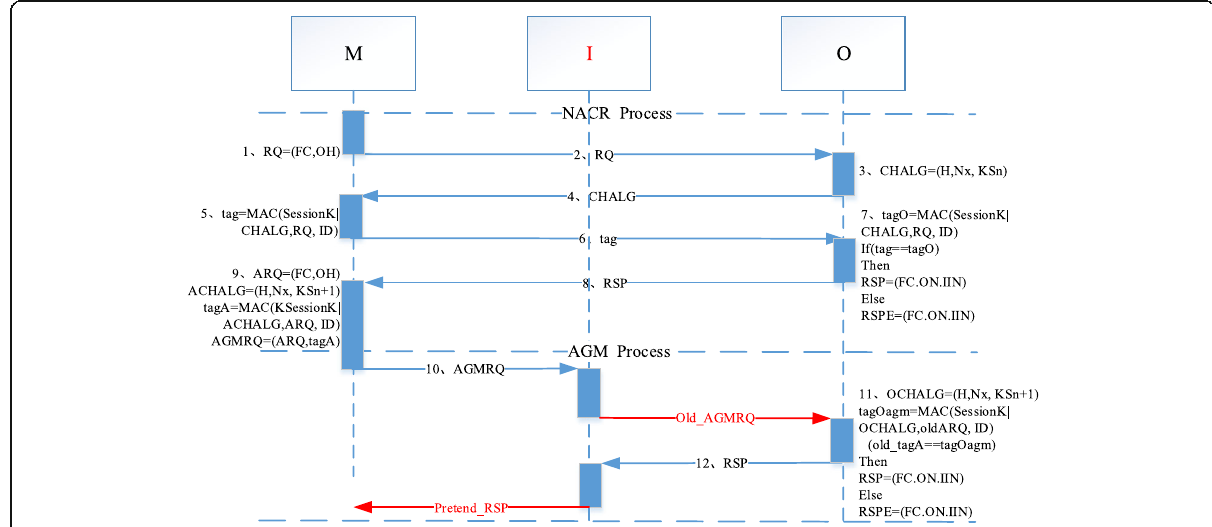
Fig. 4 The MSC model of third